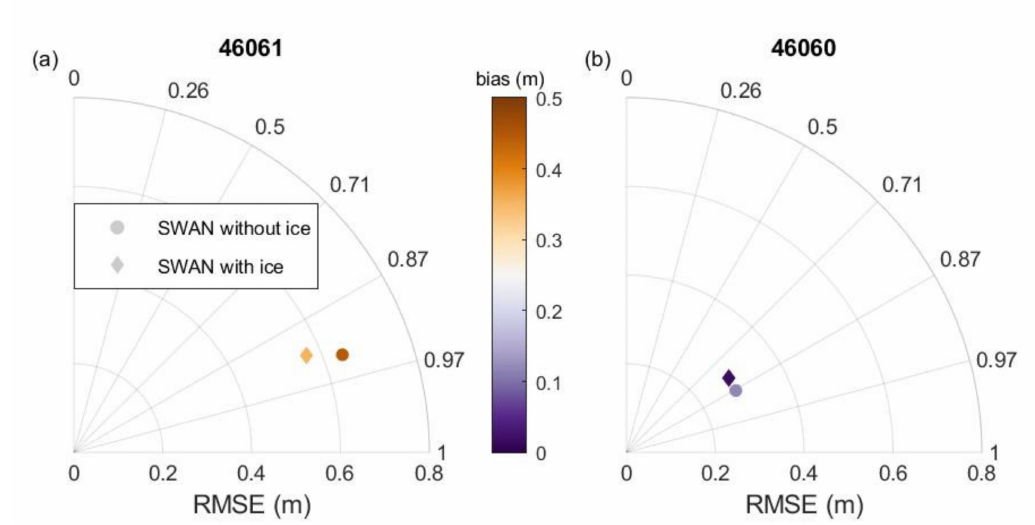
Figure 5. Root mean square error, correlation coefficient, and bias of comparisons between the SWAN model and the buoys for data from 2016–2020. The RMSE is the distance from the origin, the correlation coefficient is shown as the angle from the y-axis, and the bias is the shown as the color of the marker. ( a ) The comparison at buoy 46061 near the mouth of PWS; ( b ) the comparison at buoy 46060 inside